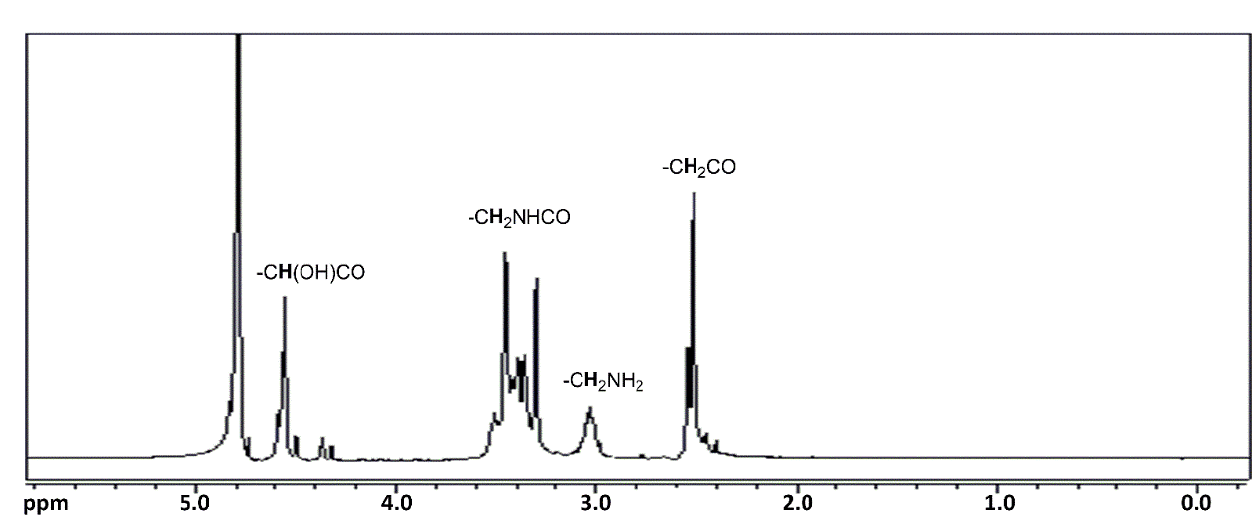
1 I = integral value of signal attributable to the labeled group, calculated with respect to the integral of the CH 2 NH 2 signal set equal to 4 (two terminal amino groups). The x, y, and z values refer to the units within the chain in the presence of two terminal amino groups. The value y + 1 refers to the total number including two terminal amino groups. 2 OA = oligoamide.